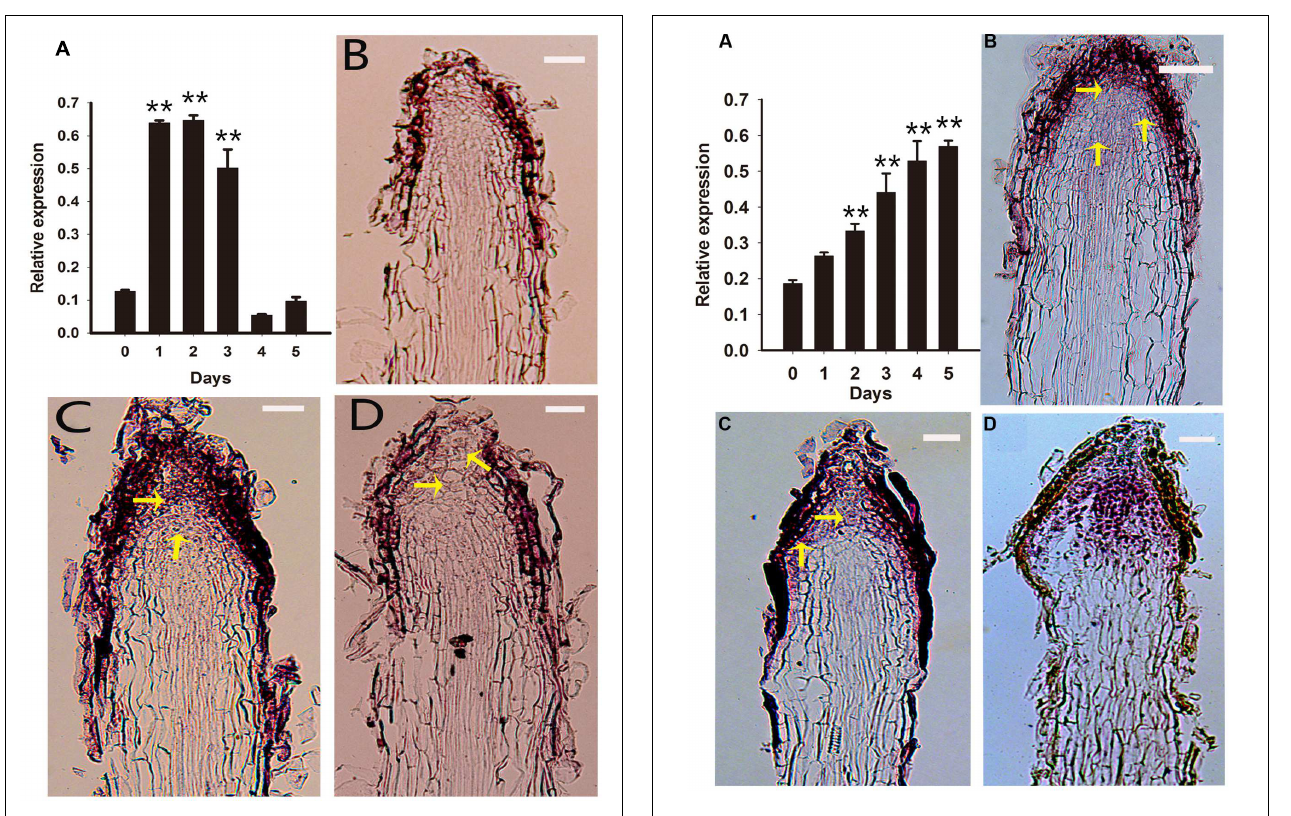
FIGURE 5 | Expression pattern of RcWUS in rhizoid tips. Rhizoid tips (1 cm long) were collected after culture on PIM for 0, 1, 2, 3, 4, and 5 days. (A) Quantitative real-time PCR analysis of RcWUS expression pattern during the first 5 days of PLB formation. Error bars represent the SE of three biological replicates. Asterisks indicate significant differences calculated using the t -test (** P < 0.01) ( n = 3 for each treatment). (B–D) In situ hybridization in longitudinal sections of rhizoid tips. RcWUS expression in rhizoid tips (B) before culture on PIM, (C) after culture for 3 days, or (D) after culture for 5 days. Bars = 2 µ m.